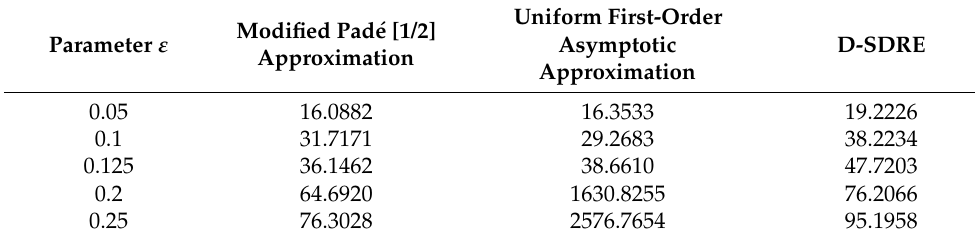
Table 2. Demonstration of extrapolation properties of the modified Pad é